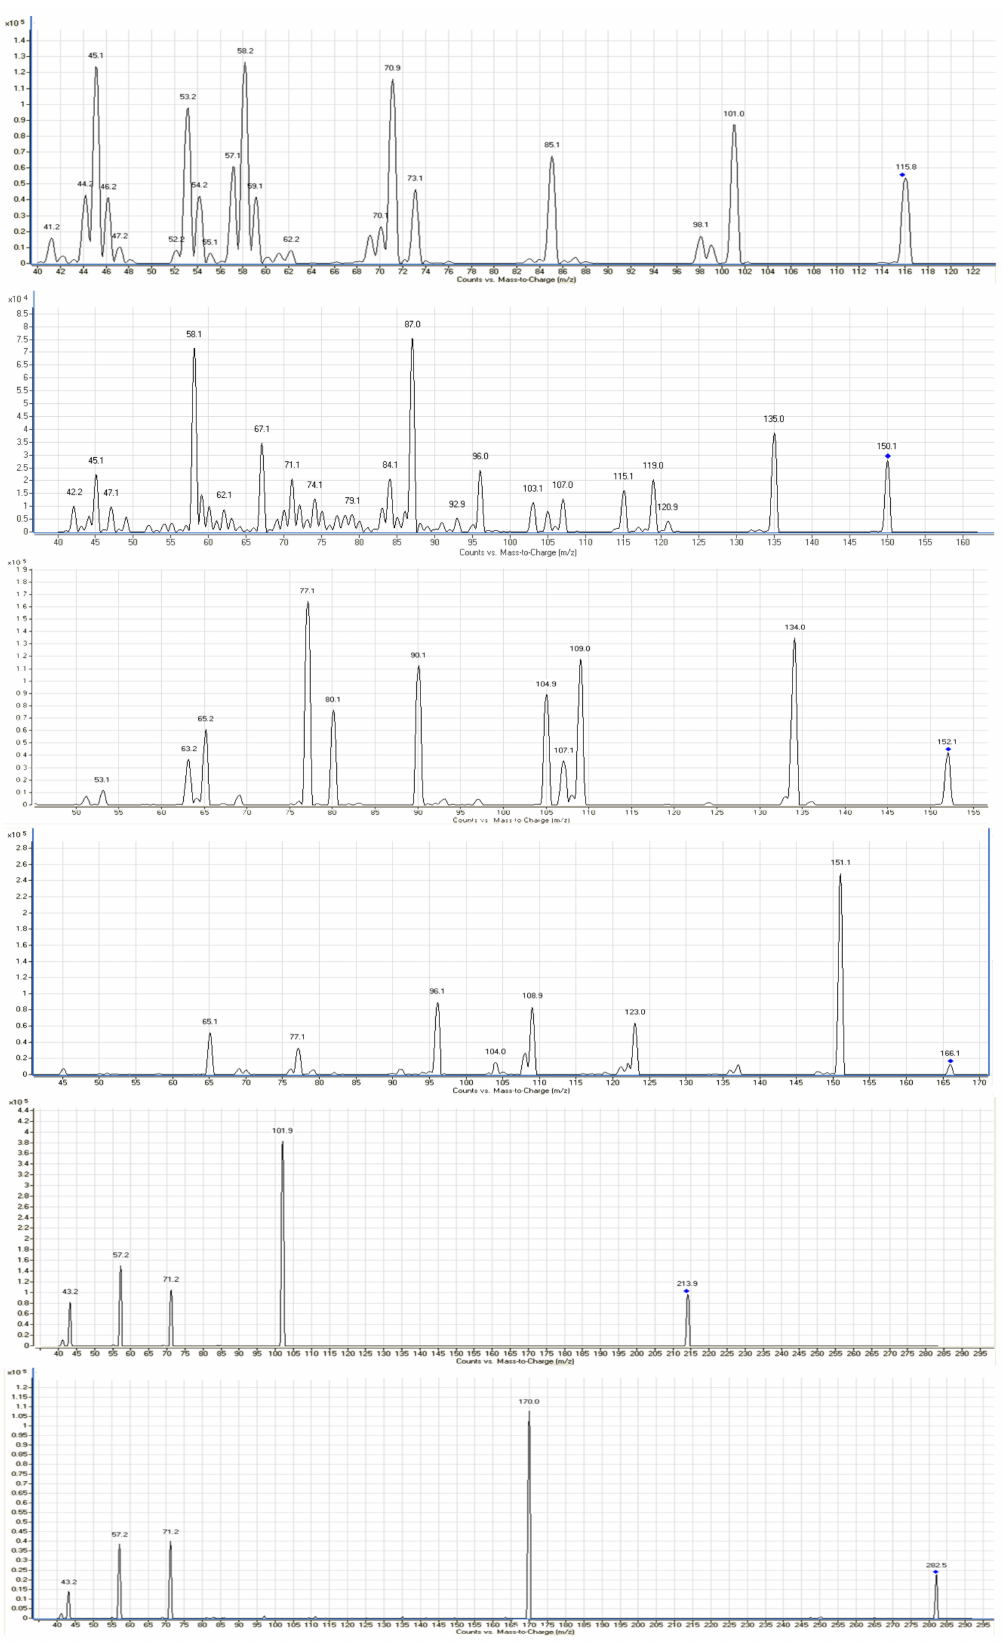
Figure 4. The MS scan and Daughter scan of